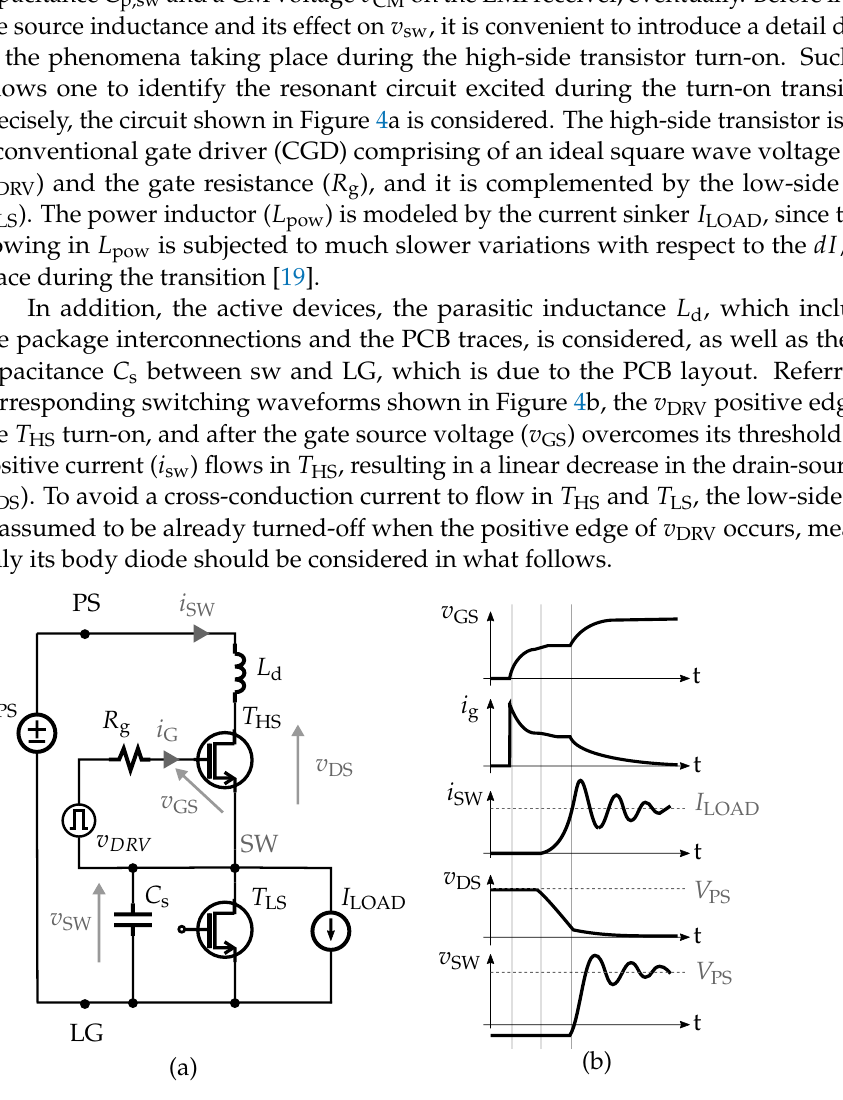
Figure 4. ( a ) Simplified model of a single leg for the analysis of the turn-on when the high-side transistor is driven by a convention gate driver and ( b ) the corresponding switching